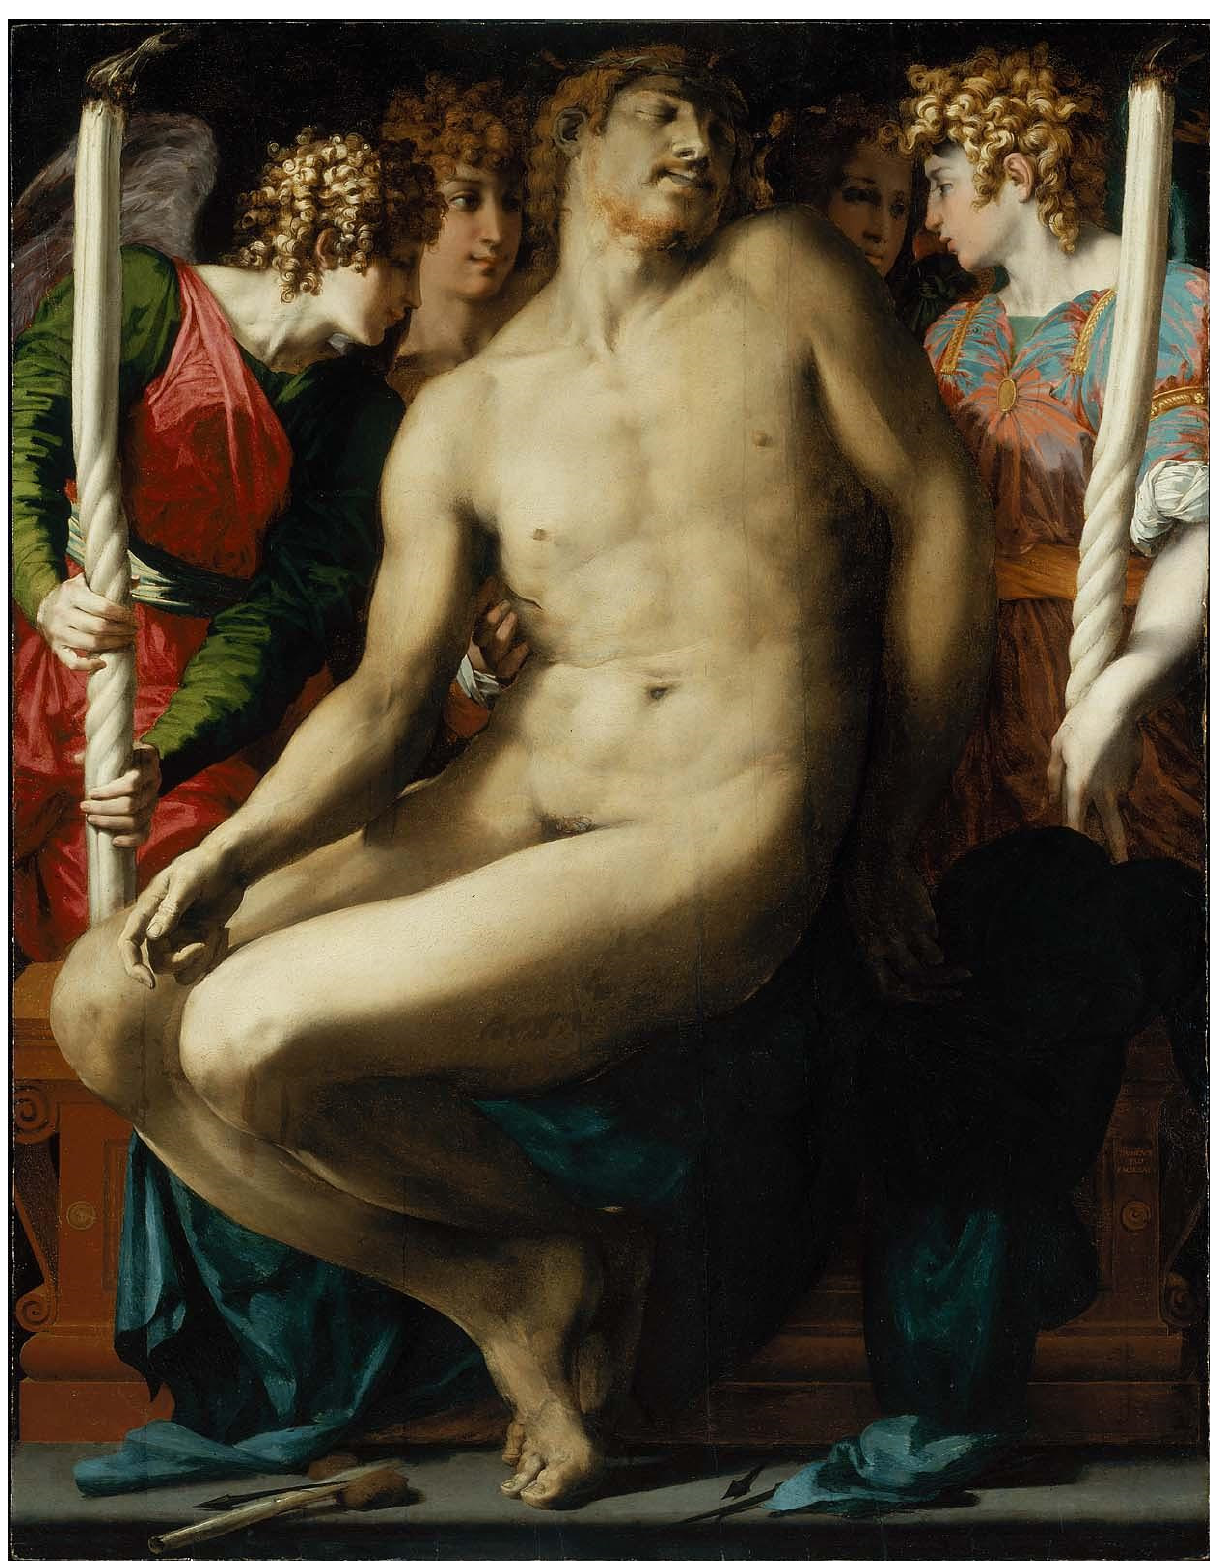
Figure 7. Rosso Fiorentino, Dead Christ with Angels , 1525. Oil on panel. Boston, Museum of Fine Arts, U.S. Image Courtesy of Museum of Fine Arts, Boston, U.S. Charles Potter Kling Fund.